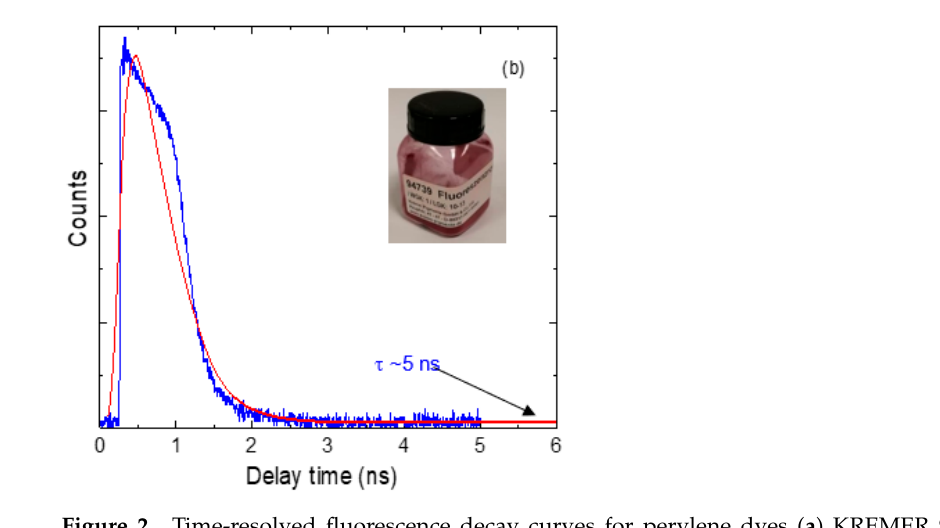
Figure 2. Time-resolved fluorescence decay curves for perylene dyes ( a ) KREMER 94720 and ( b ) KREMER 94739.